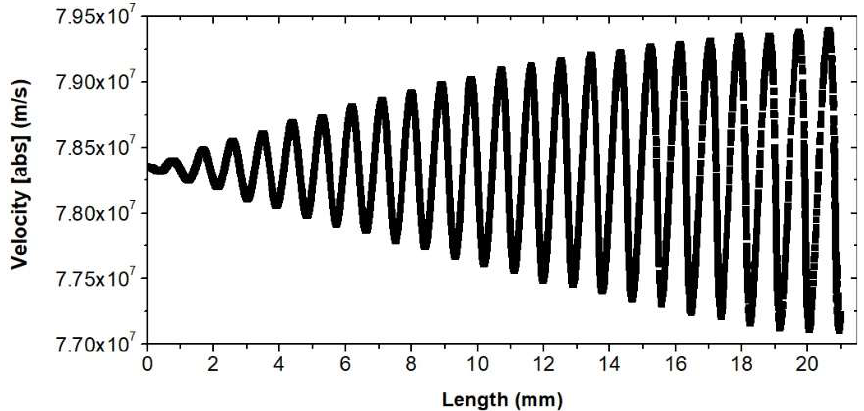
Figure 21. The phase space graph of electron beam in modulation section of PA-HHTWT.